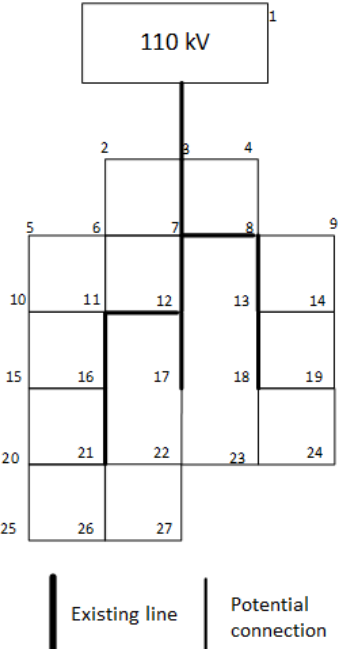
8 of 19 Table 3. Parameters of new lines. Line Cross Section [mm 2 ]